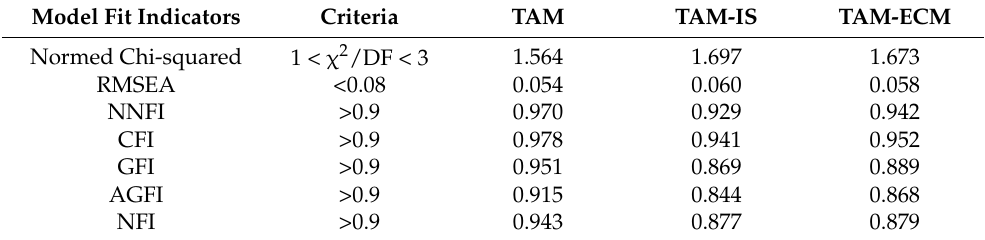
Table 4. Model fit.